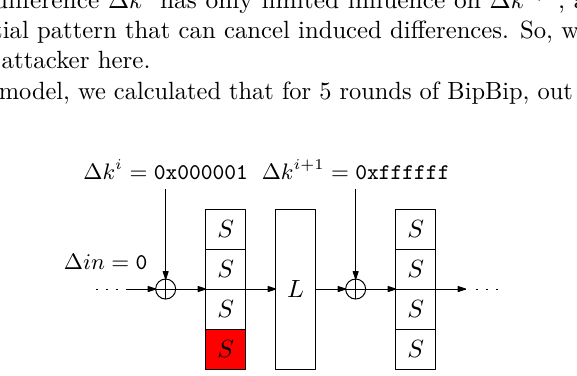
Figure 3: Example for model that assumes the differences always cancel. The active S-boxes are in